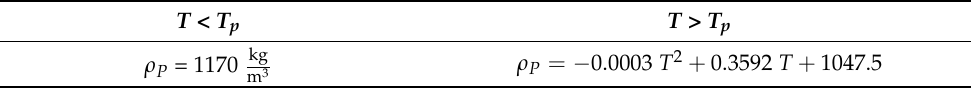
Table 1. Matrix density of CFRP as a function of the pyrolysis temperature